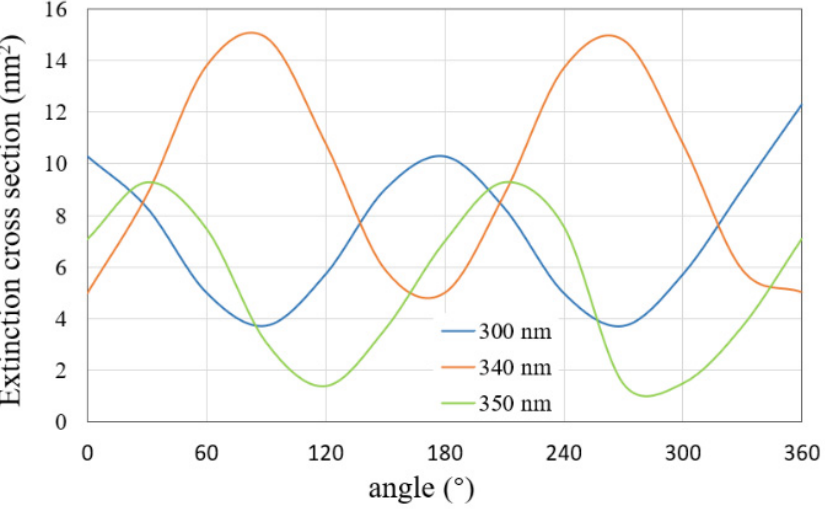
Figure 10. ECSs of the nanocylinder array with the incident angle varying from 0 ◦ to 360 ◦ for different wavelengths.